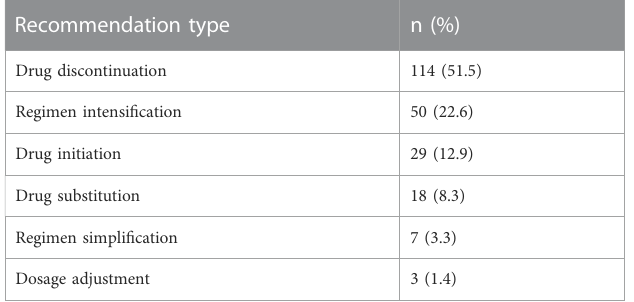
TABLE 5 List, number and proportion of recommendations made to physicians ( N =